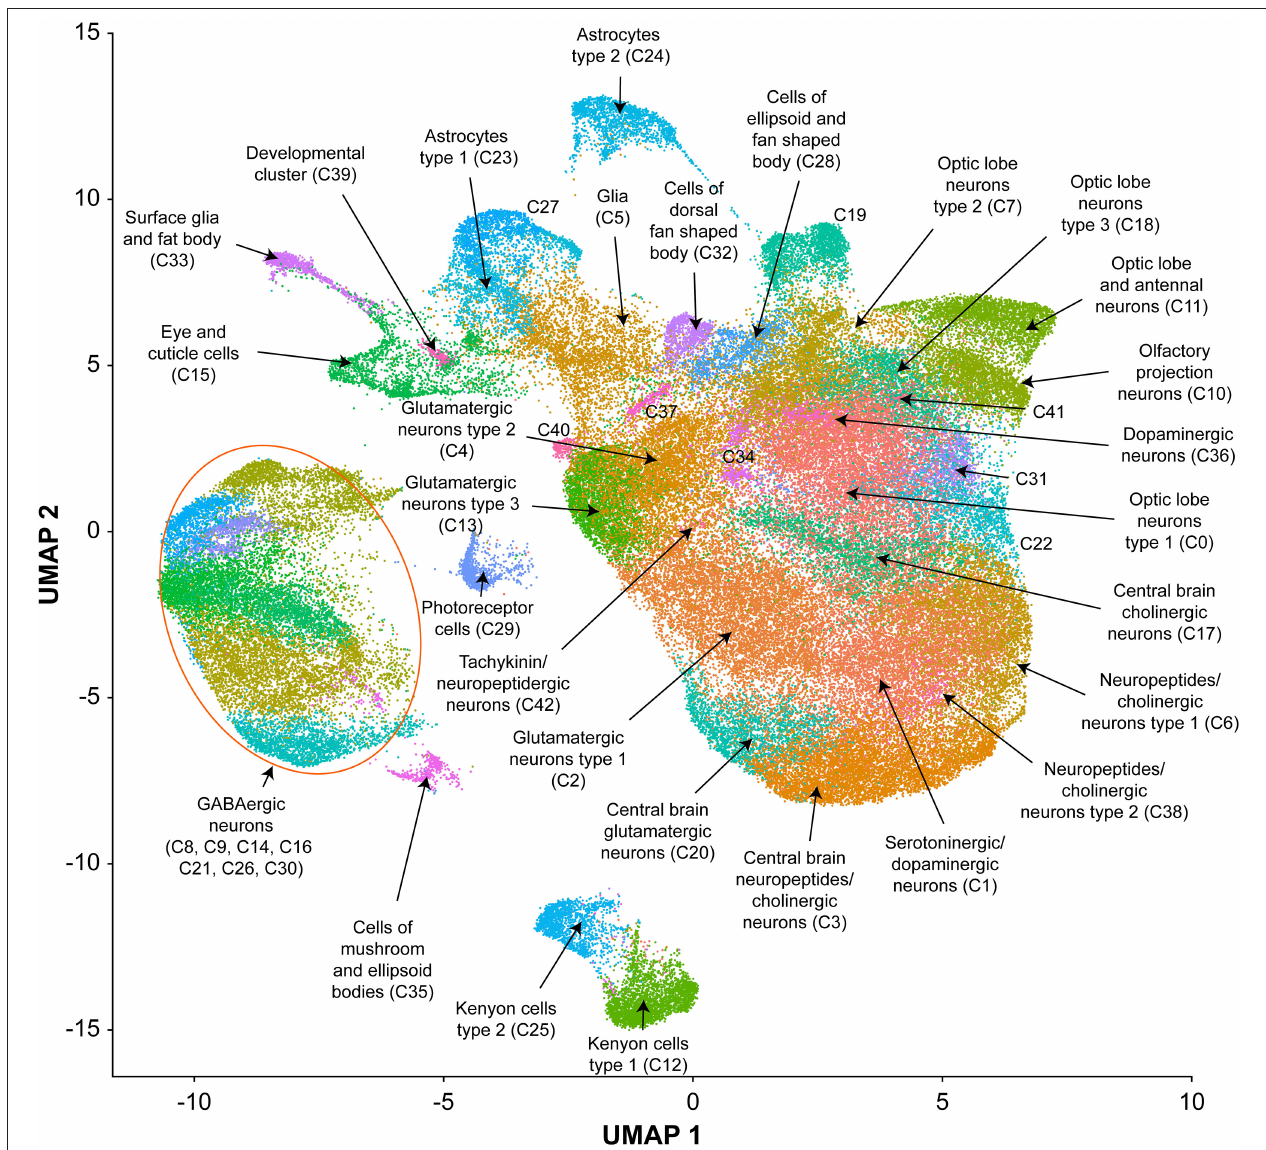
FIGURE 4 | UMAP visualization and annotation of cell clusters. Cells were clustered based on their expression pattern using the unsupervised shared nearest neighbor (SNN) clustering algorithm. Individual dots represent each cell and the colors of the dots represent the cluster to which the cells belong. Annotation of cell types from clusters was performed by cross-referencing cluster-defining genes across FlyBase (30) and published literature ( Supplementary Table 3